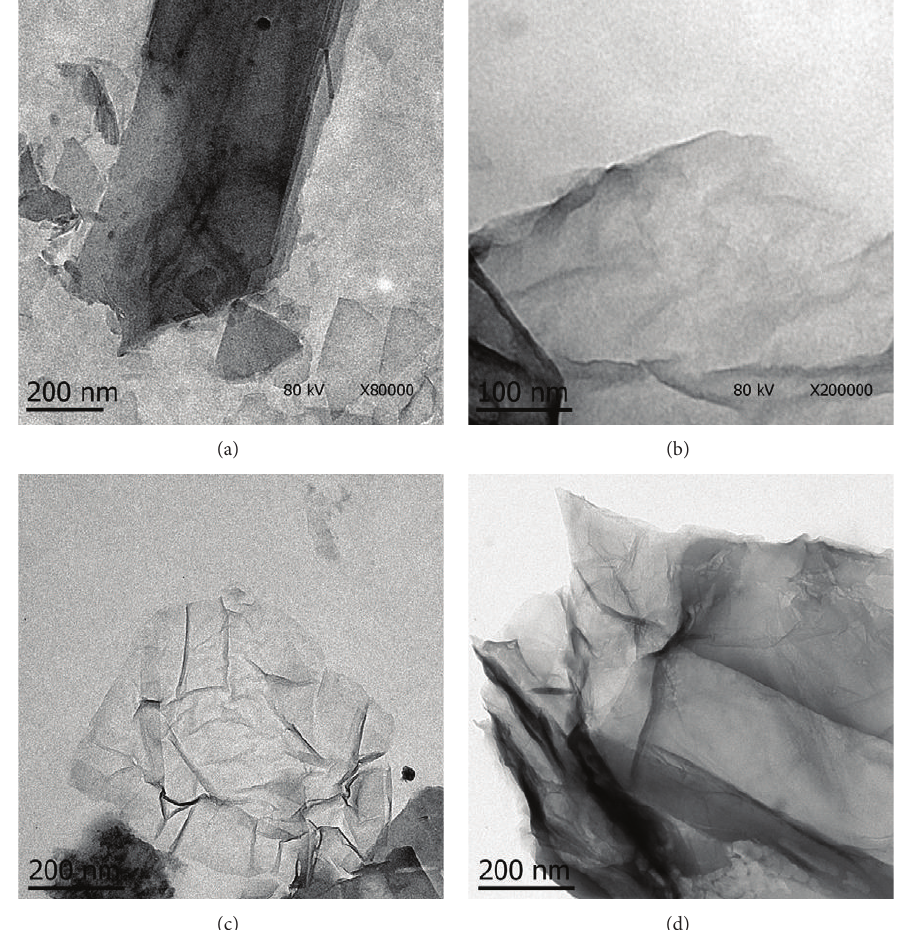
Figure 2: TEM images of (a)-(b) graphene oxide (GO) and (c)-(d) reduced graphene (RGO).